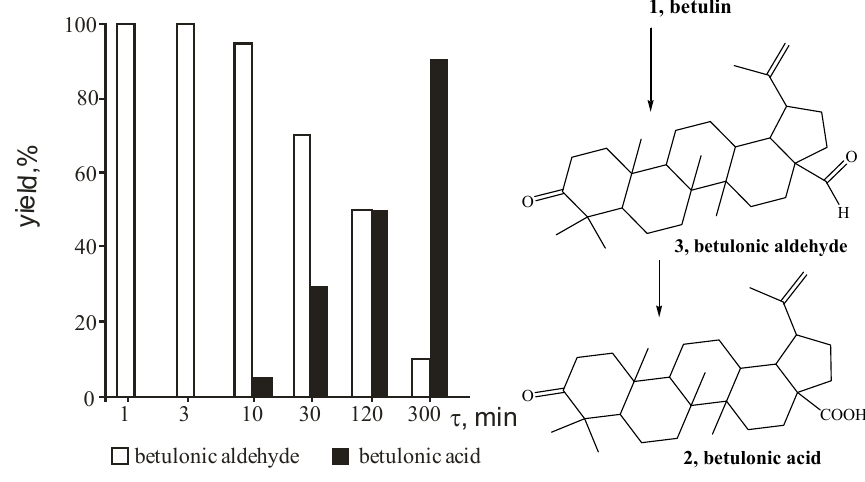
Figure 2. Diagram of yields of betulonic acid (black colour) and betulonic aldehyde (white colour) in